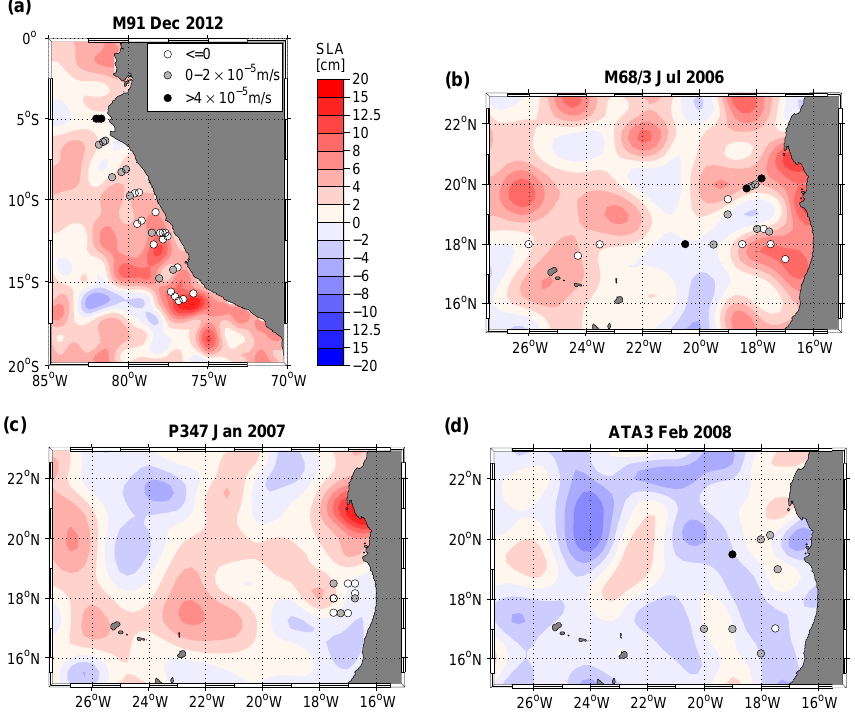
Figure 7. Mean sea level anomaly over the time period of the respective cruise for M91 (a) , M68/3 (b) , P347 (c) , and ATA3 (d) . The difference between helium- and wind-derived vertical velocity is indicated by the grey dots. For details see